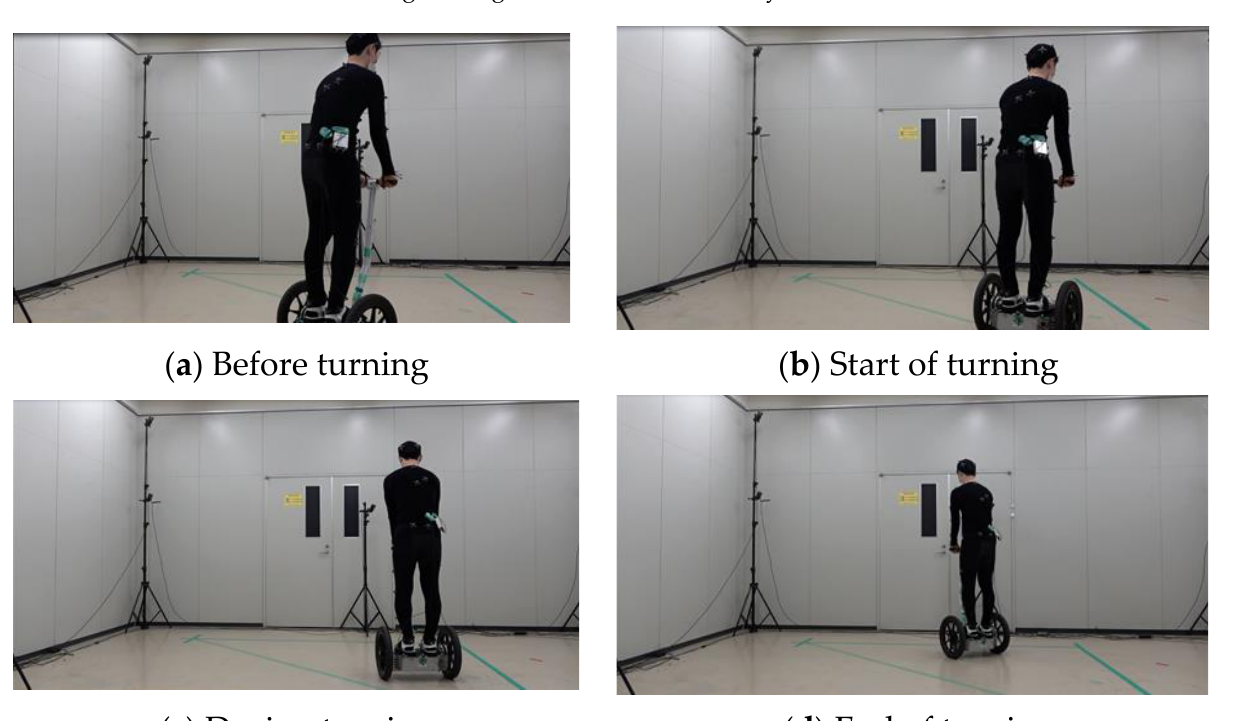
Figure 3. Turning experiment.